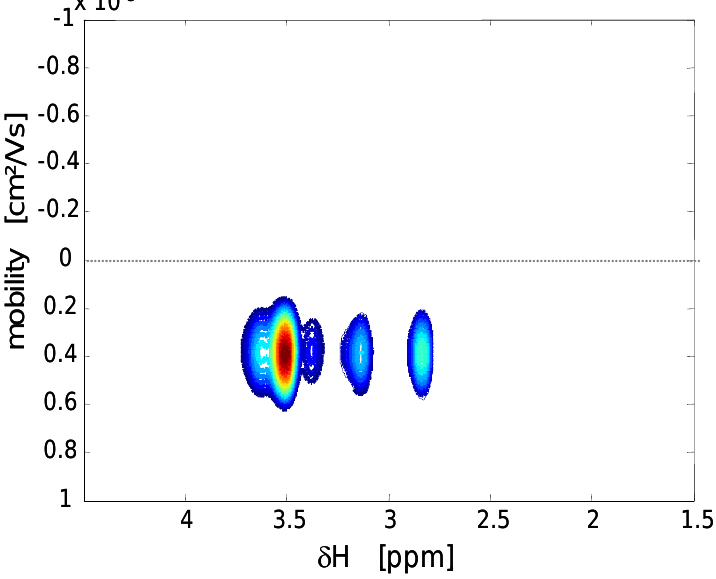
Figure 3. Two-dimensional electrophoresis NMR spectrum of PAMAM G2 at pH